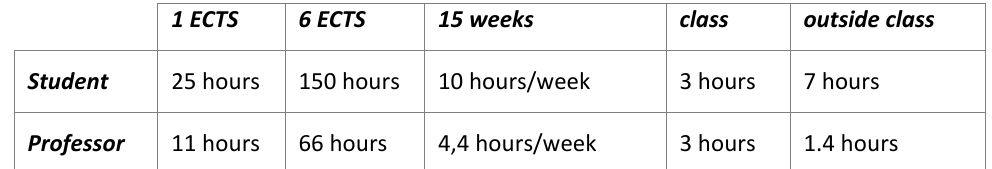
Table 1: Summary of the time devoted by students and